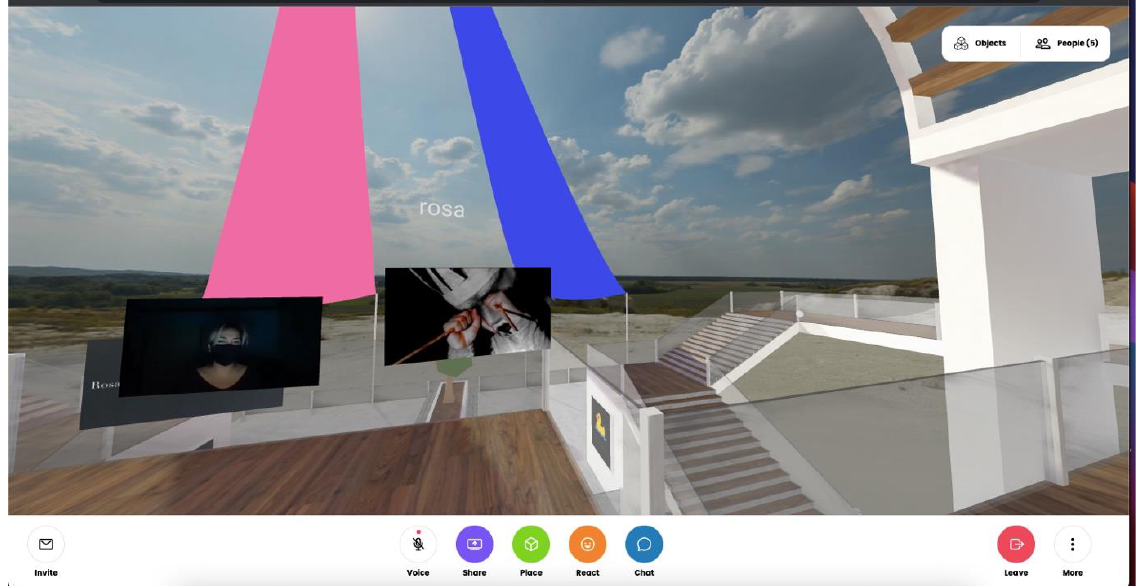
Figure 5: Student’s Artist Projects in a digital -game exhibition through Mozilla Hubs (3D Space) 101G Semester